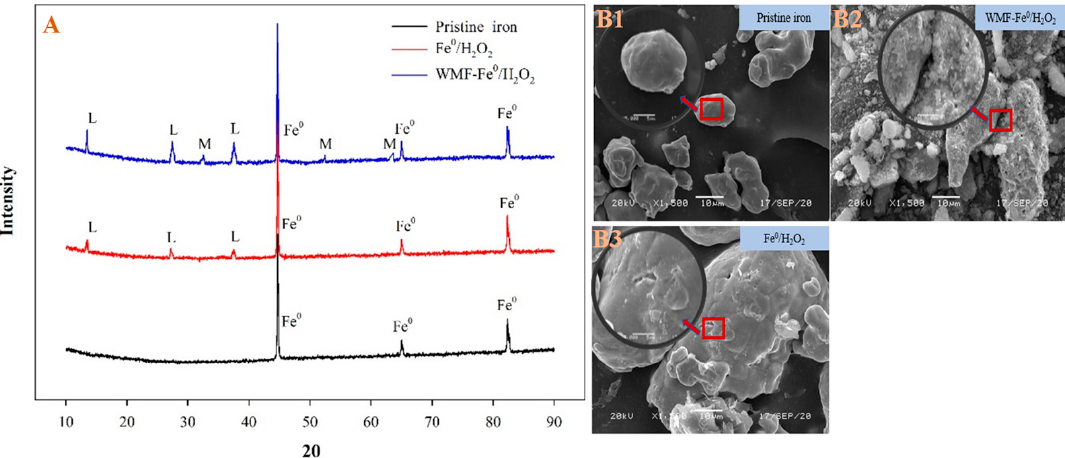
Figure 3. XRD patterns ( A ) and SEM images ( B1 – B3 ) of Fe 0 particles at different conditions. Reaction conditions: pH = 5.0, [BPA] 0 = 0.2 mM, [Fe 0 ] 0 = 7 mM, [H 2 O 2 ] 0 = 6 mM, [Cl − ] = 2 mM.